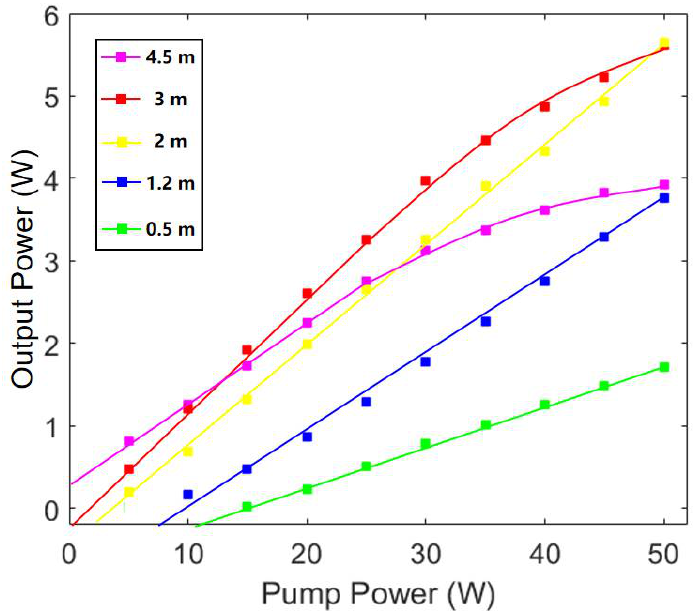
Figure 6. Variation of output power with pump power under different fiber lengths in the PA system.